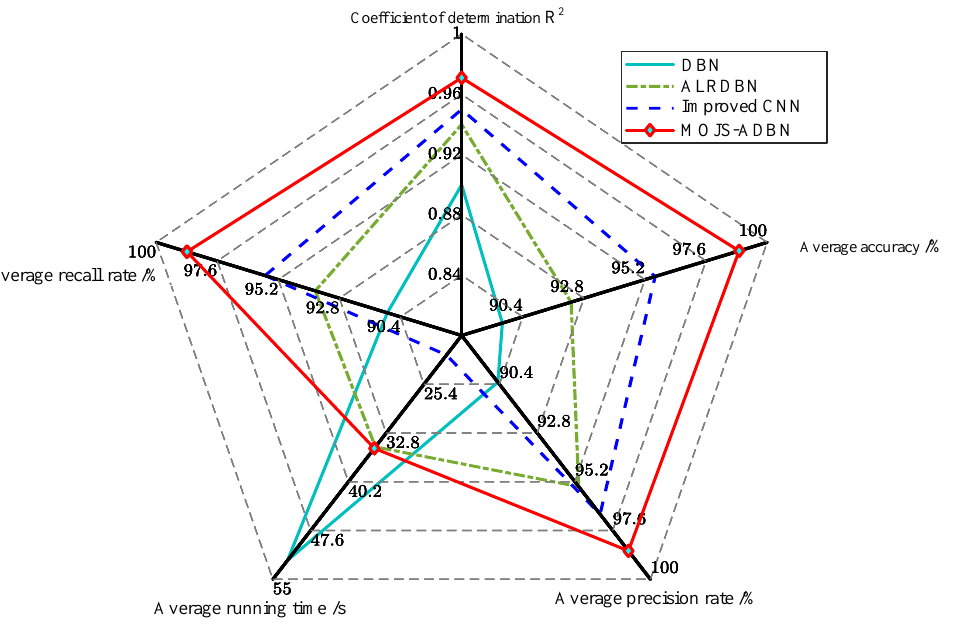
Figure 9. Performance comparison results of the ablation experiments.